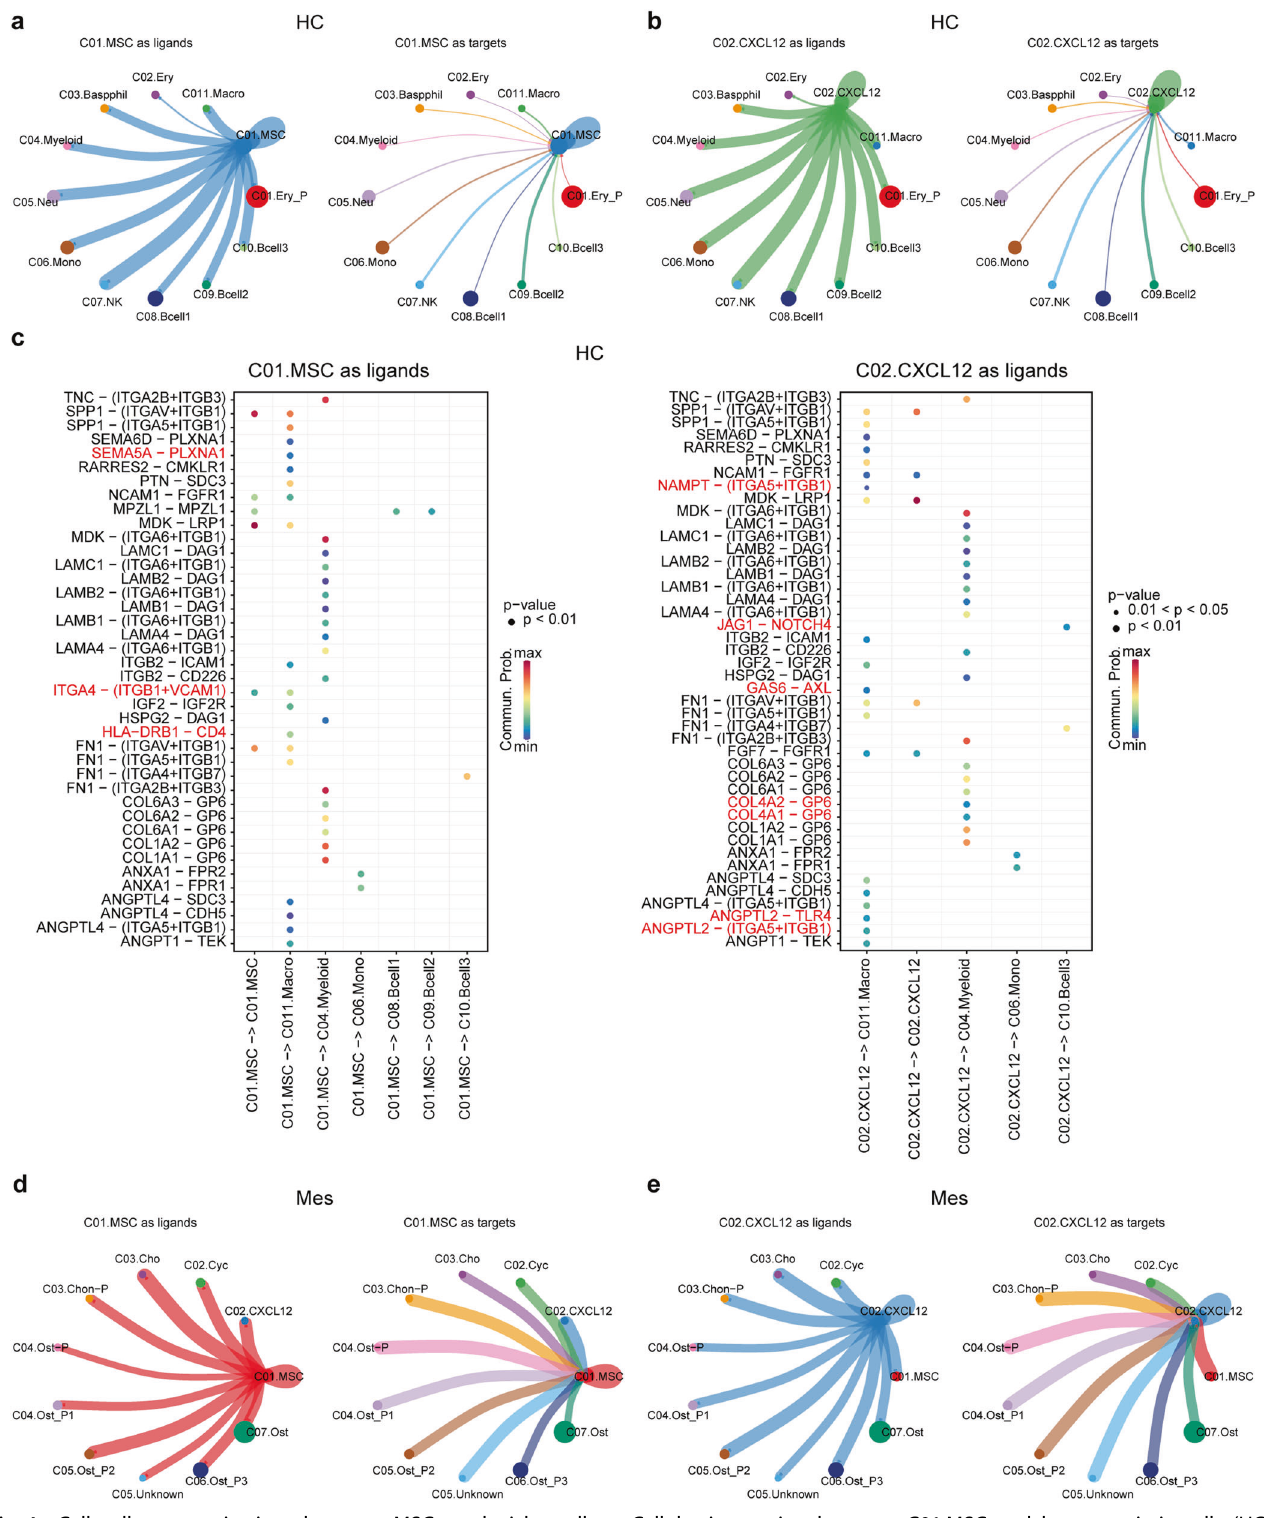
Fig. 4 Cell – cell communications between MSCs and niche cells. a Cellular interaction between C01.MSC and hematopoietic cells (HC). b Cellular interaction between C02.CXCL12 and hematopoietic cells (HC). c Unique ligand-receptor pairs between MSCs and hematopoietic cells. The red ligand-receptor pairs indicate the differences between C01.MSC and C02.CXCL12. d Cellular interaction between C01.MSC and mesenchymal cells (Mes). e Cellular interaction between C02.CXCL12 and mesenchymal cells (Mes)